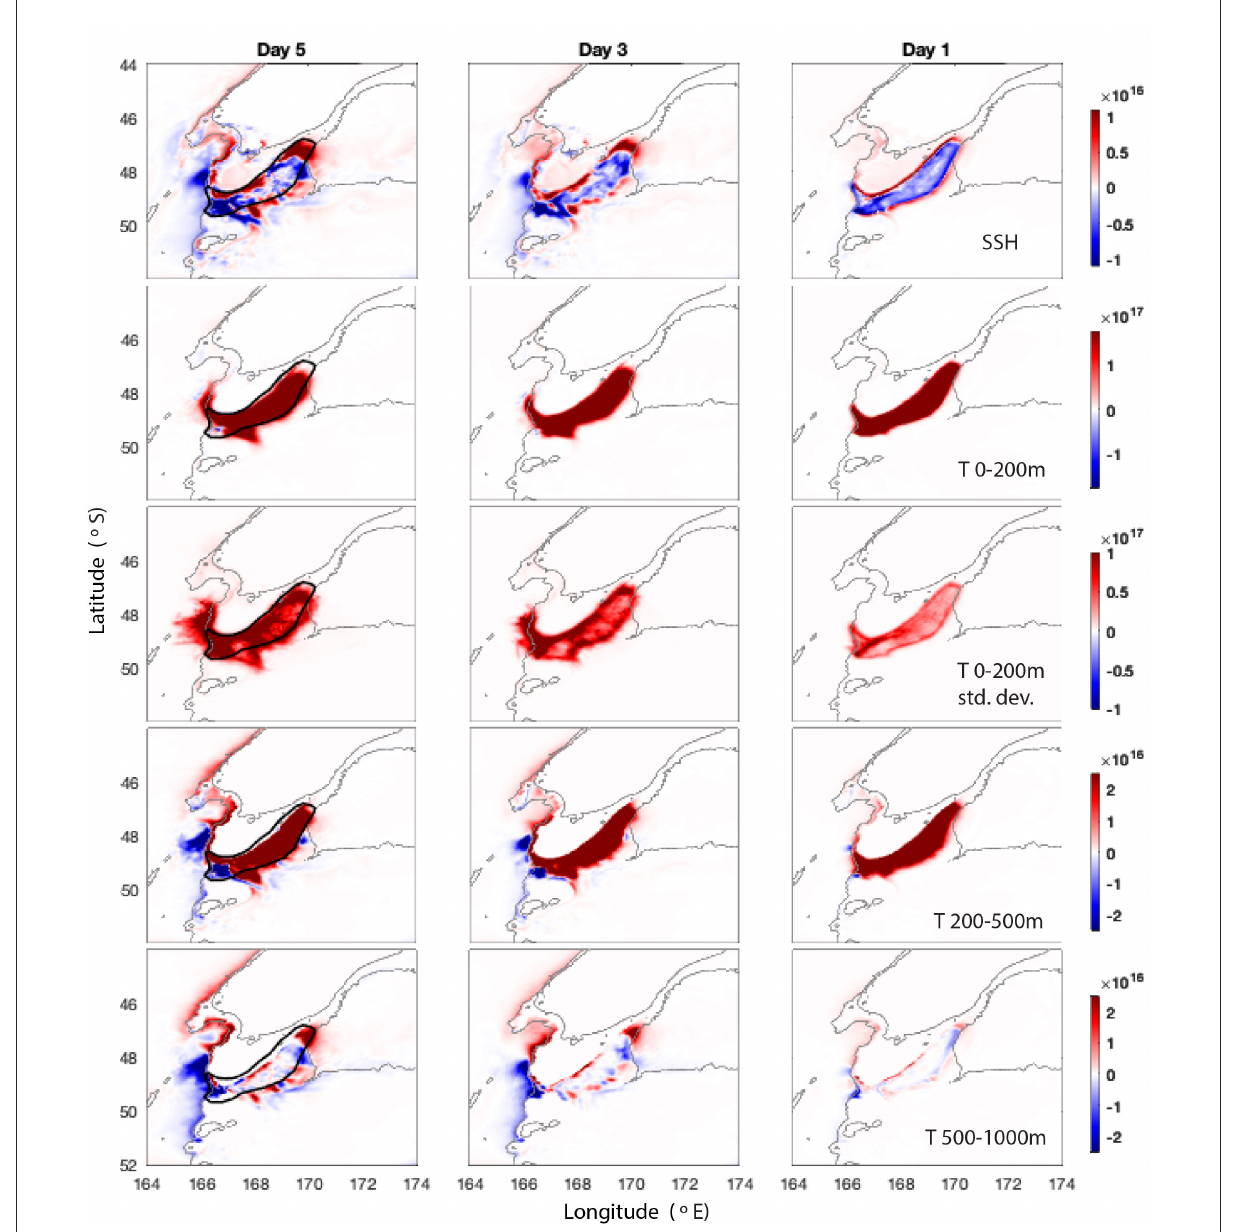
FIGURE12 Ensemble sensitivities for days 5, 3, and 1 leading up to all 52 MHW events in the Stewart Plateau and Snares Shelf region. (Top to bottom) : Mean scaled sensitivity to SSH, mean scaled sensitivity to temperature from 0 to 200 m, standard deviation of scaled sensitivity to temperature from 0 to 200 m, mean scaled sensitivity to temperature from 200 to 500 m and mean scaled sensitivity to temperature from 500 to 1,000 m. Sensitivities are scaled by the 5-day standard deviations for the days leading up to the MHWs, averaged in quadrature. Gray lines show the 100 and 1,000 m bathymetry